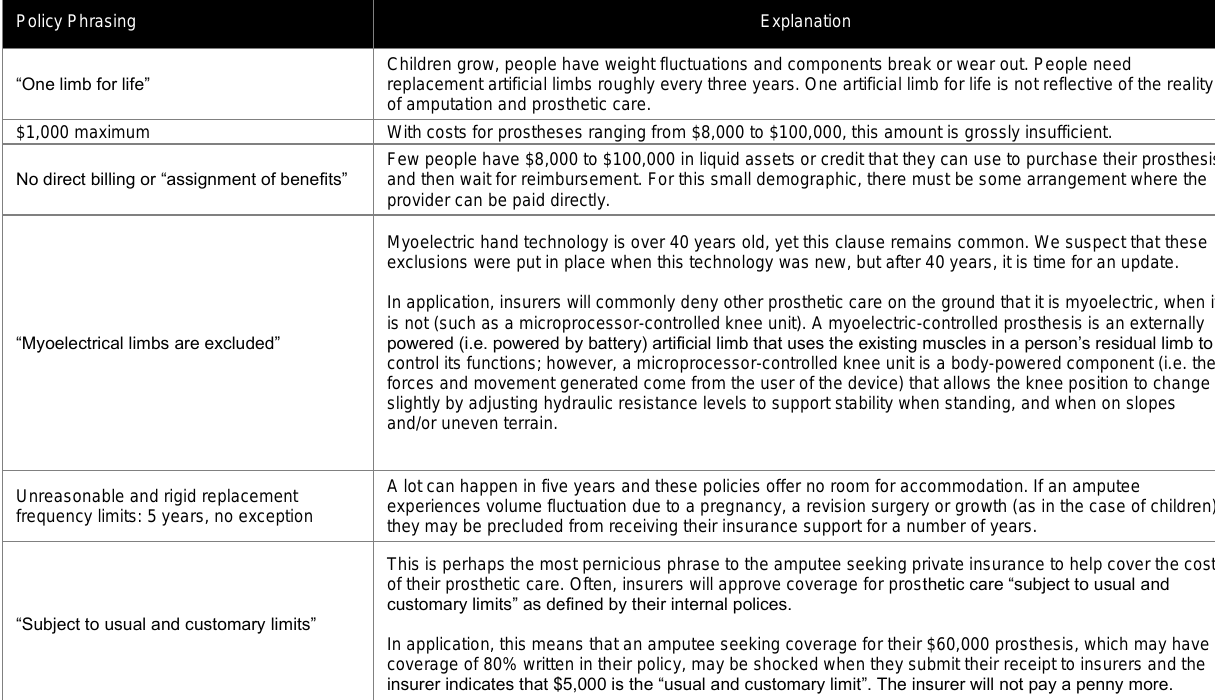
Table 4: Arbitrary Policy Phrasing. Policy Phrasing